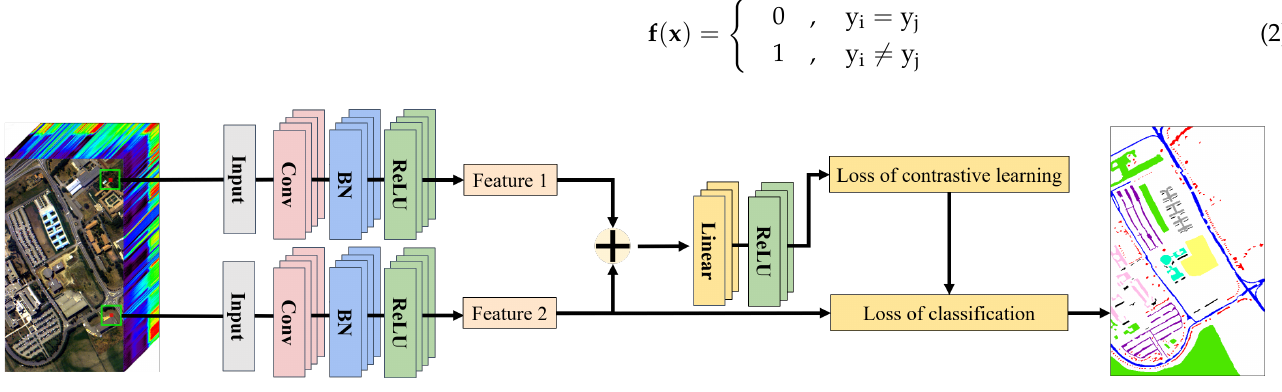
Figure 2. Graphical illustration of dual learning-based siamese network